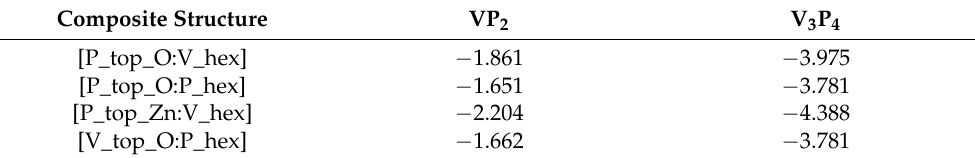
Table 3. Stacking energies ( E stack ) for non-stoichiometric VP/ZnO composites, eV. Composite Structure